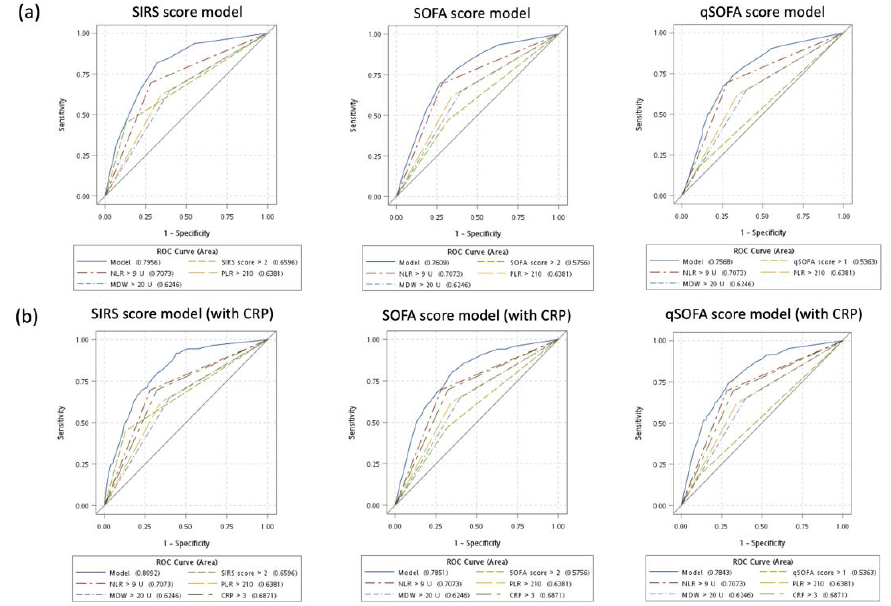
Figure 2. Receiver of operating characteristic (ROC) curves of predicting sepsis for models based on SIRS score, SOFA score, and qSOFA score. ( a ) Models without CRP. ( b ) Models with CRP.